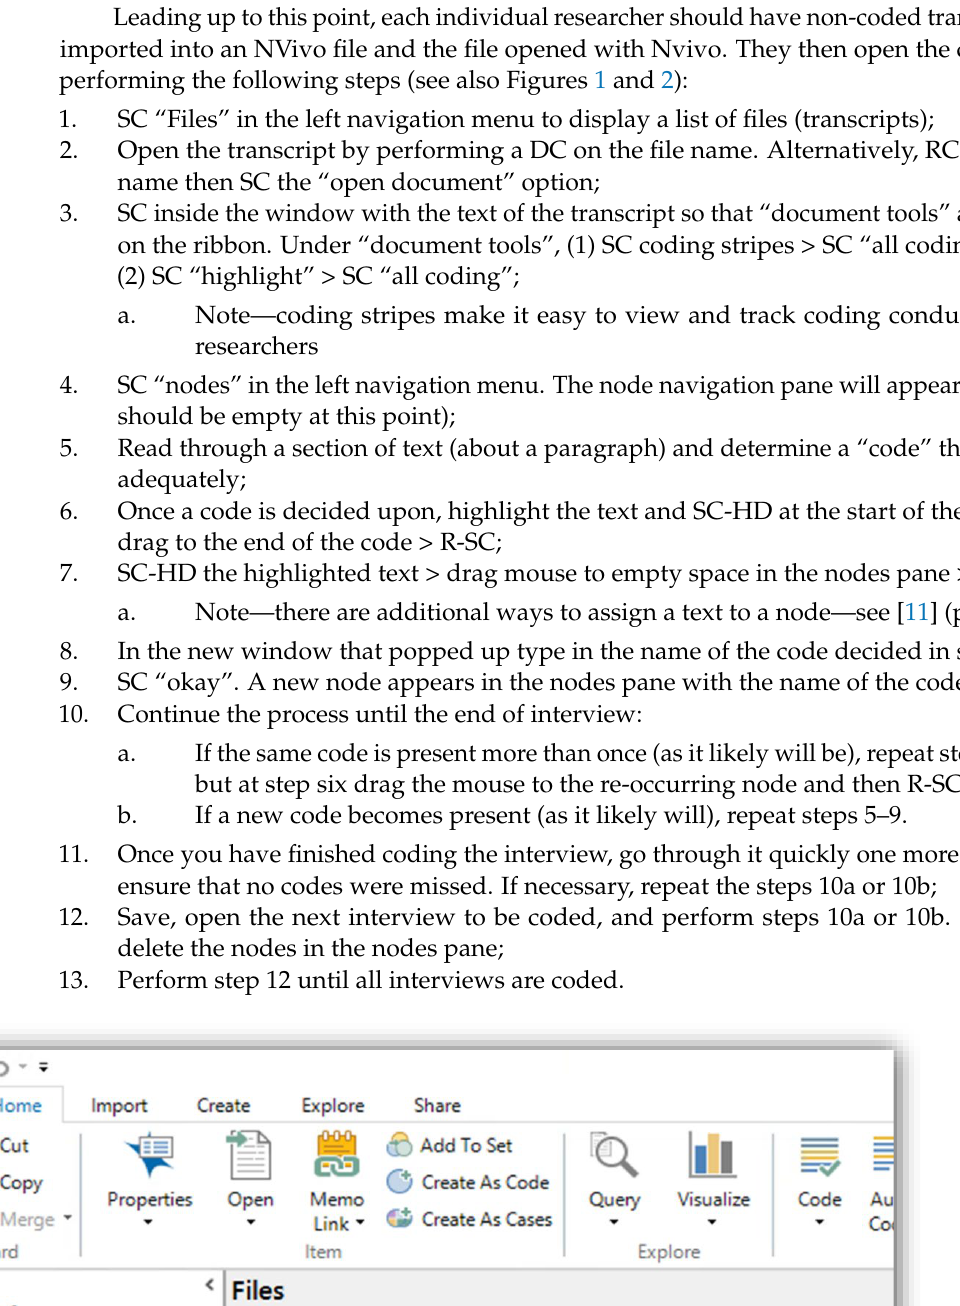
Figure 2. Open coding with the entire interview method screenshot 2 (Steps 4–8). 3.2. Open Coding through the Deep Dive Method Coding using the deep dive method is similar to the entire interview method. The key difference is that instead of open-coding a collection of interviews, the researcher open-codes previously coded nodes. To perform open coding using this method, a